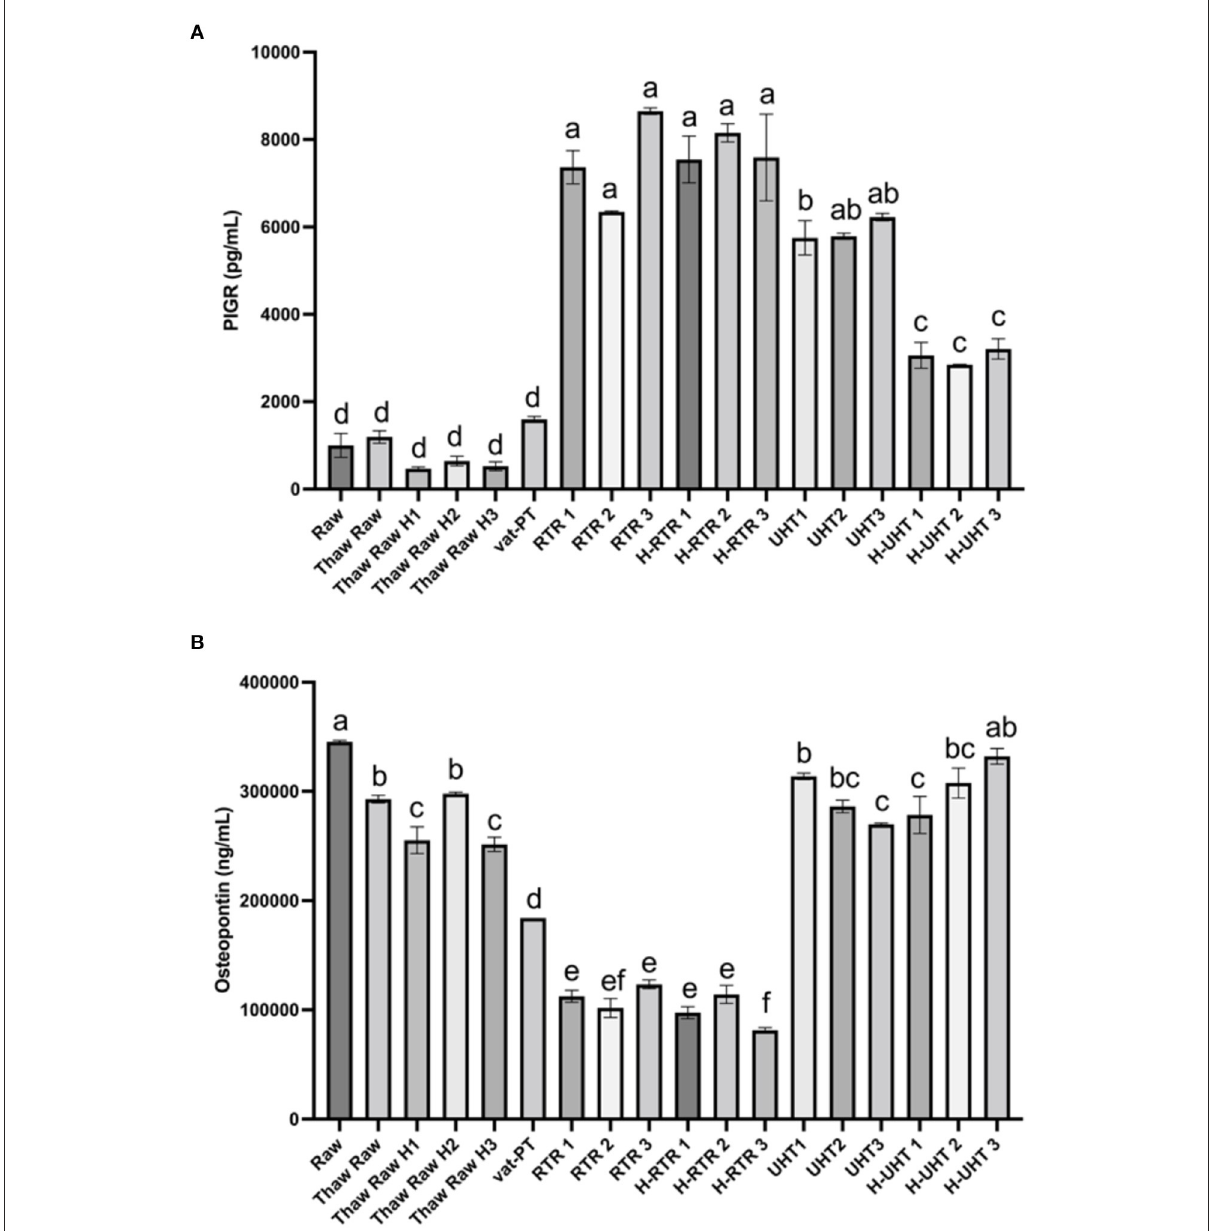
FIGURE4 (A) PIGR and (B) osteopontin concentrations in the donor human milk samples: raw milk (Raw), thawed raw milk (Thaw Raw), thawed and homogenized raw milk (Thaw Raw H1, 2, and 3), vat-pasteurized milk (Vat-PT), retort treated milk (RTR 1, 2, and 3), homogenized and retort treated milk (H-RTR 1, 2, and 3), ultra-high-temperature treated milk (UHT 1, 2, and 3), and homogenized and ultra-high-temperature treated milk (H-UHT 1, 2, and 3). One-way analysis of variance (ANOVA) with post hoc Tukey’s tests were used to identify significant ( p < 0.05) differences between treatments, denoted by